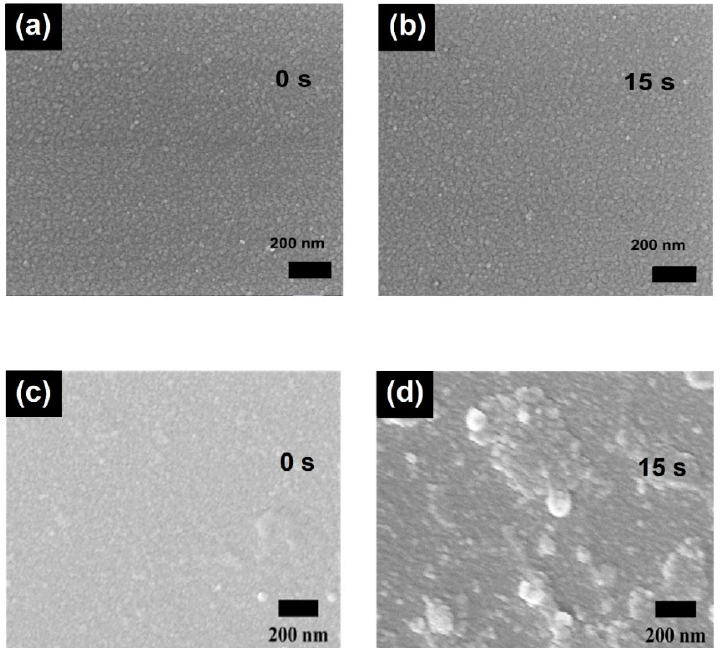
Figure 4. SEM images of the Cr/Al/Cr/TiN anode under the ultrasonic treatment for ( a ) 0 s and ( b ) 15 s; SEM images of the Cr/Al/Cr/Mo anode under the ultrasonic treatment for ( c ) 0 s and ( d ) 15 s. The work function (WF) of Cr/Al/Cr/TiN with different thicknesses of TiN was esti ‐ mated by means of ultraviolet photoelectron spectroscopy (UPS) [32,33]. Figure 5 shows their photoemission spectra in the secondary electron cutoff and valence band regions.